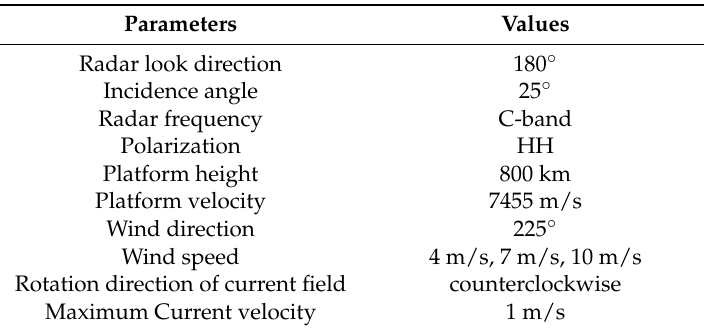
Table 7. The simulation parameters of Figure 16.